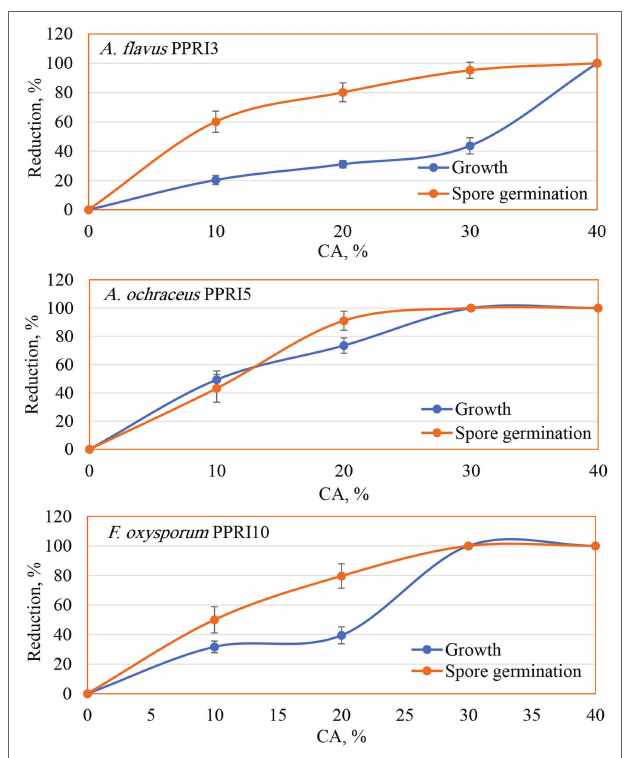
FIGURE 4 | Reduction of growth and spore germination of toxinogenic fungi as affected by various crude CA concentrations.